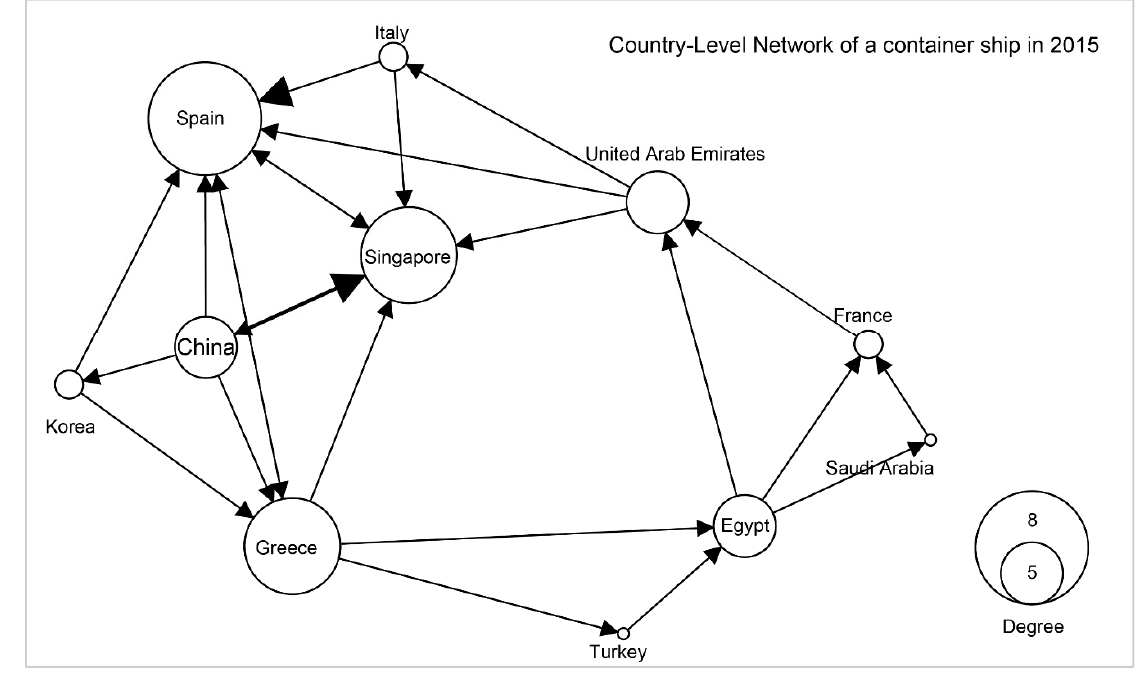
Figure 5. Country-level network of a container ship with 11 nodes in 2015.